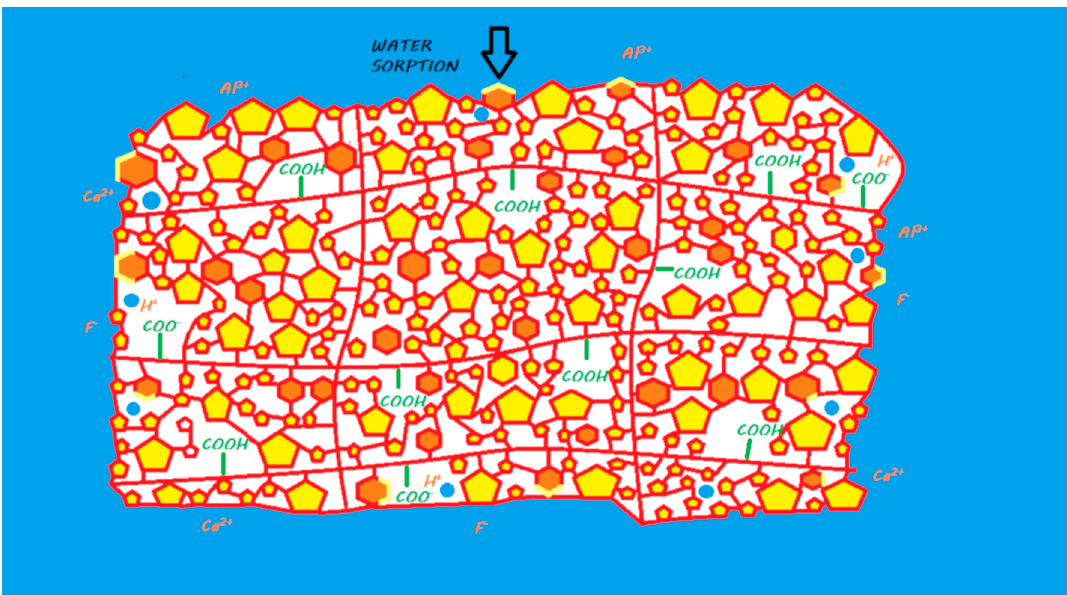
Figure 12. Ion release from a compomer once it is in contact with the oral environment. When the material is light cured, a resin polymerization reaction is initiated, and monomers can copolymerize with other monomers, silanated FAS fillers, and unreactive fillers. The acidic groups remain dehydrated, and no acid–base reaction occurs in the setting reaction of the material. When placed in a moist environment (i.e., oral environment), water sorption occurs, and dehydrated acidic monomers located in the periphery of the material can release protons to attack silanated FAS fillers. This mechanism leads to the release of calcium, aluminum, and fluoride ions. These ions do not participate in the setting mechanism of the material.